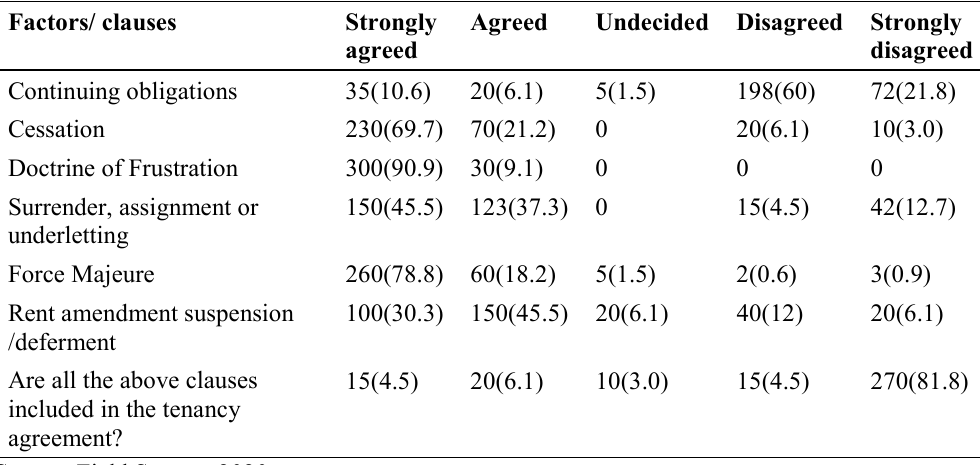
Table 3. Determining Factors or Clauses for the Adequacy of the